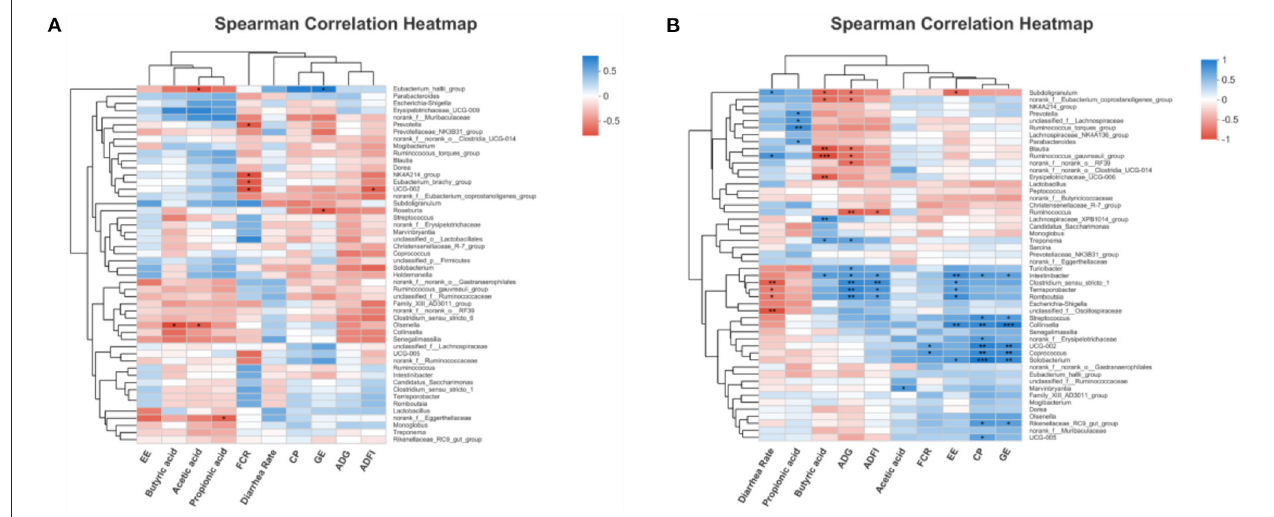
FIGURE 9 | Correlation heatmap analysis among performance indices and significantly differential bacteria for (A) 14d-piglets and (B) 28d-piglets. ADG, average daily gain; ADFI, average daily feed intake; GE, gross energy; CP, crude protein; FCR, feed conversion ratio; EE, ether extract. Ctrl, corn-soybean basal diet;